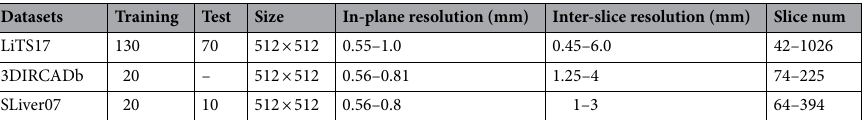
Table 1. The specifications of the experimental datasets (“–” means none).